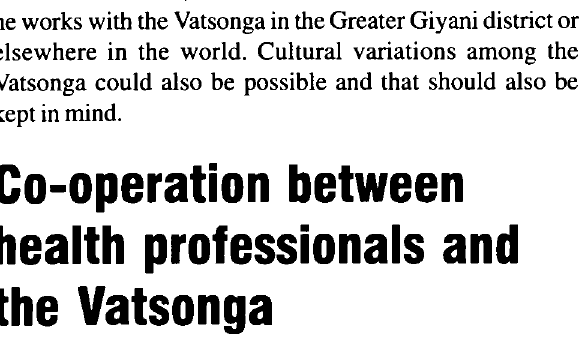
Figure 4.1 explains how the Vatsonga